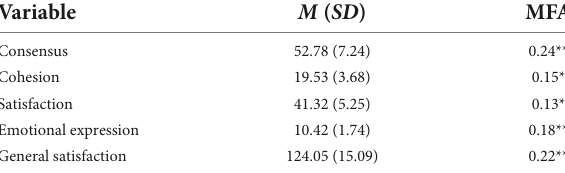
TABLE 5 Pearson’s linear correlation coefficient for the relation between relationship quality and maternal–fetal attachment (MFA). Variable M ( SD )